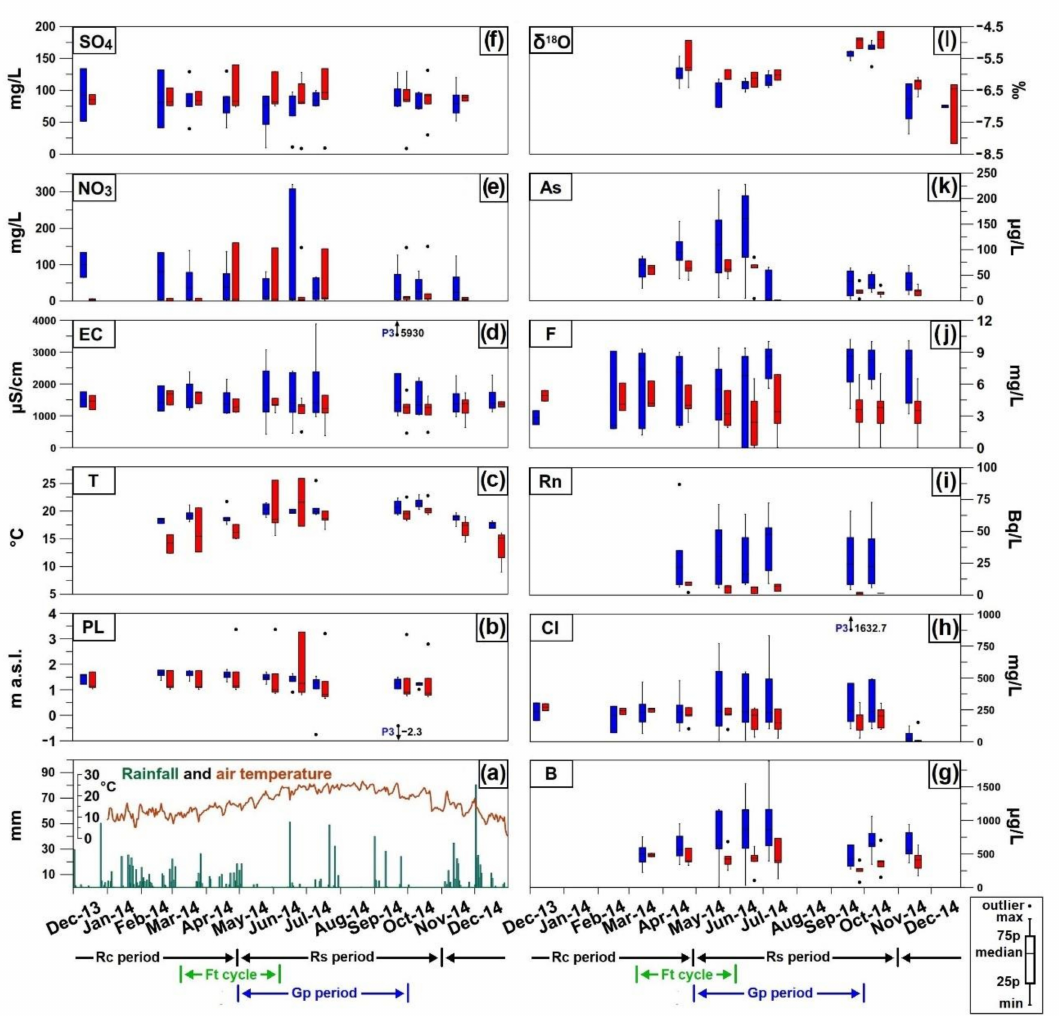
Figure 5. Box plots of climatic, hydrogeological, and hydrogeochemical parameters for the whole monitoring period, with indication of recharge (Rc), recession (Rs), fertilization (Ft) and pumping (Gp) phases; ( a ) rainfall and air temperature; ( b ) piezometric levels; ( c ) groundwater temperature; ( d ) electric conductivity; ( e ) concentration of NO 3 − , ( f ) SO 42 − , ( g ) B, ( h ) Cl − , ( i ) 222 Rn, ( j ) F − , ( k ) As and ( l ) δ 18 O isotopic ratios. Box plots represent the distributions measured in shallow (red) and deep (blue)